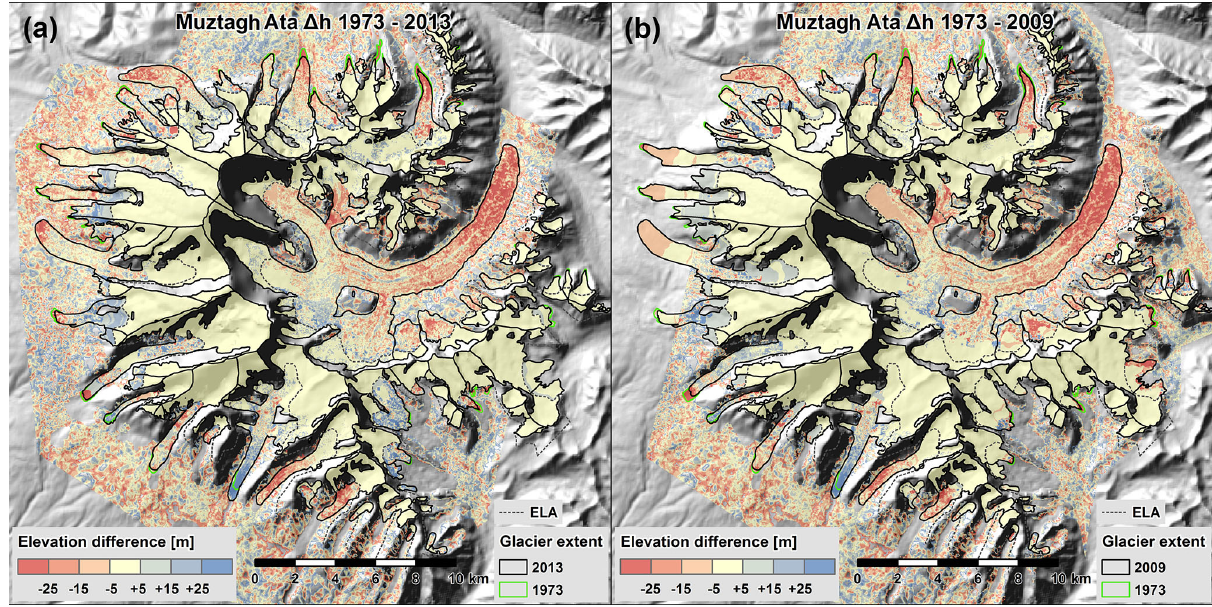
Figure 6. Co-registered map of elevation differences during 1973–2013 (a) and 1973–2009 (b) after outlier and gap-filling processing for glacier mass-balance and vertical uncertainty calculation.